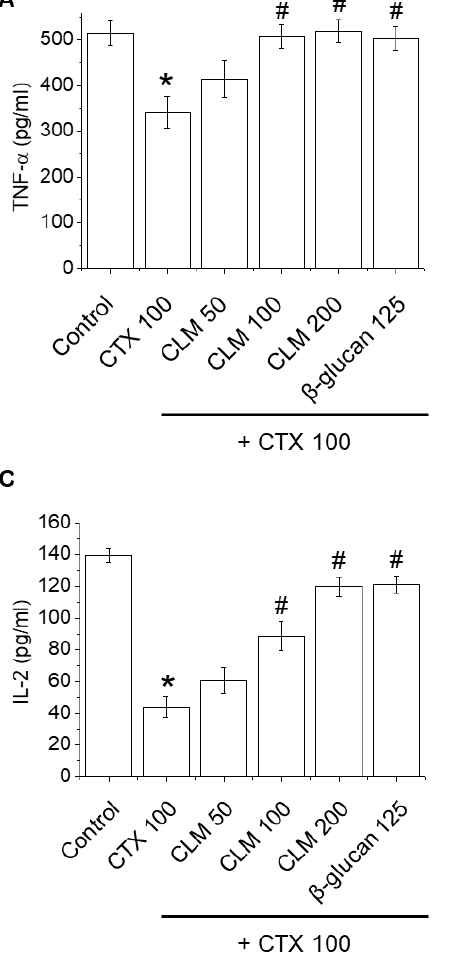
Figure 2. Effect of orally administered CLM on the levels of TNF- α ( A ), IFN- γ ( B ), and IL-2 ( C ) in CTX-immunosuppressed mice. CLM (50, 100, and 200 mg/kg/day) suspended in saline was administered orally once daily for 14 days. Mice were treated on days 7 – 9 by intraperitoneal injection of CTX (100 mg/kg/day) in a total volume of 100 µL of saline. The control group was treated with vehicle alone. Cytokines were assayed using commercial ELISA kits. Data are expressed as mean ± SD ( n = 6). * p < 0.05 vs. normal group; # p < 0.05 vs. CTX-treated group.